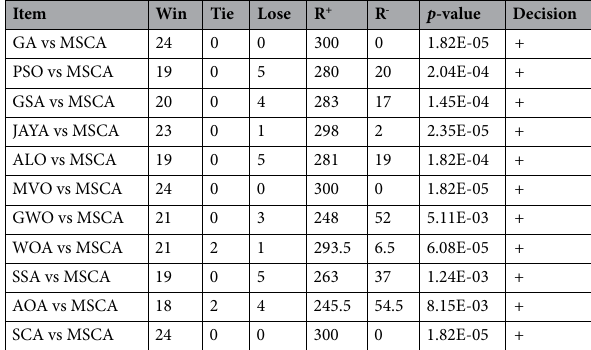
Table 5. Wilcoxon signed-rank test on classical benchmark functions at 5% level of